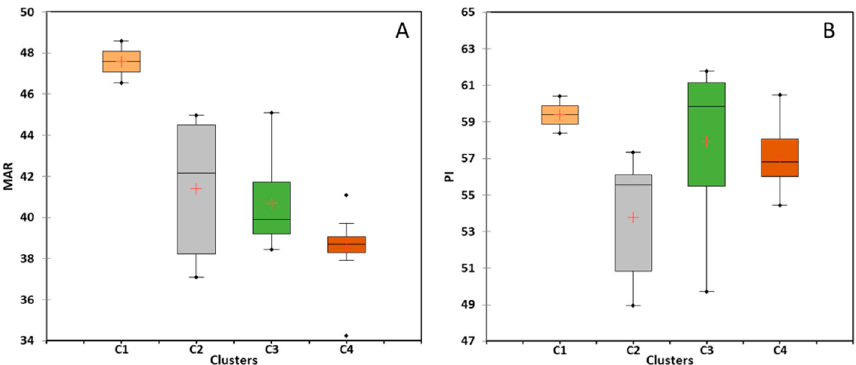
Figure 9. Plot showing the variation of the ( A ) MAR index and ( B ) PI of the tested GW. (C1, C2, C3, and C4) (+ represent the median